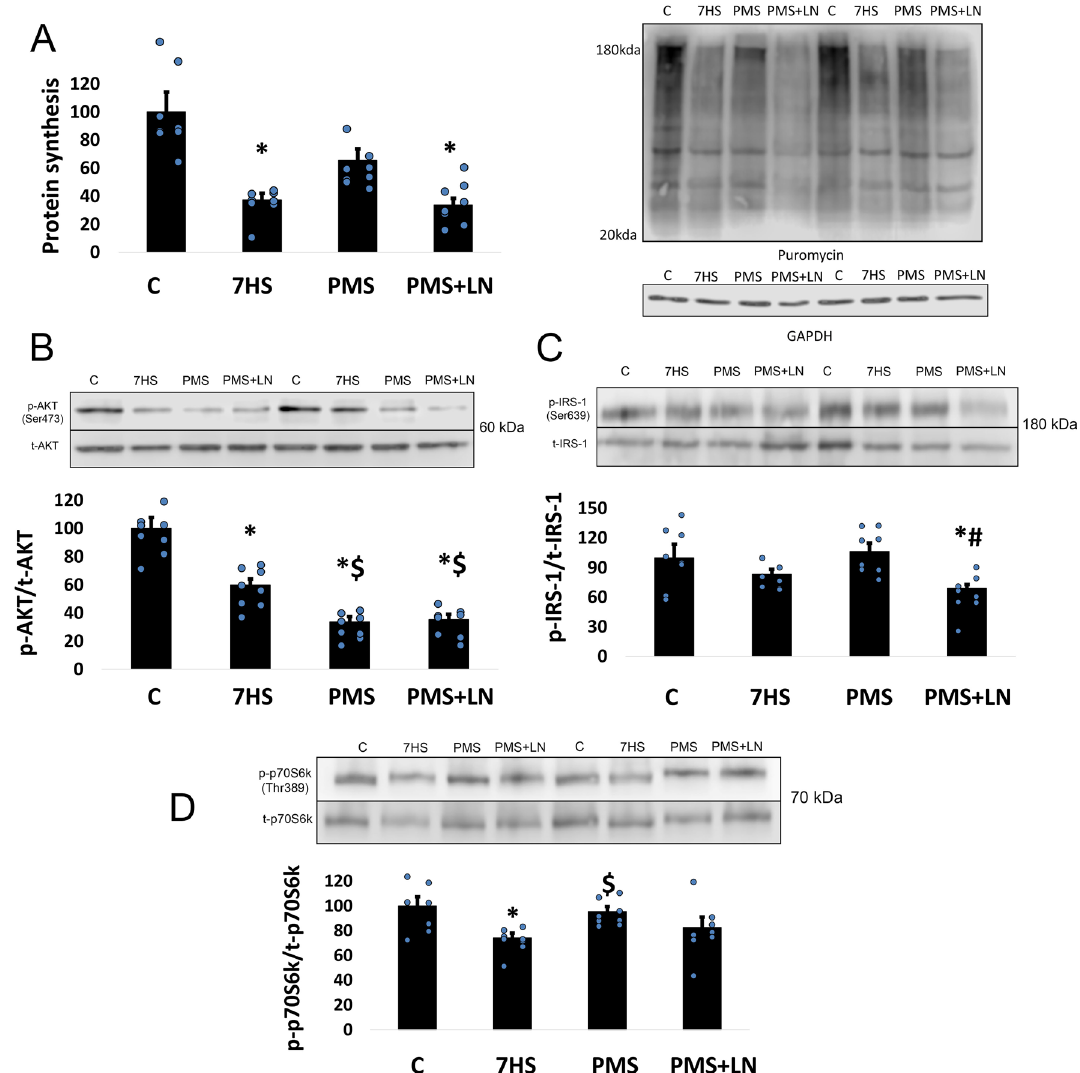
Figure 3. ( A ) Quantification of protein synthesis level. ( B ) Quantification of phospho-AKT (Ser473)/total AKT ratio. ( C ) Quantification of phospho-IRS-1 (Ser639)/total IRS-1 ratio. ( D ) Quantification of phospho-p70S6k (Thr389)/total p70S6k ratio. Control group ( C ); 7-days hindlimb-suspended group (7HS). 7-days hindlimb suspended group with plantar mechanical stimulation (PMS); 7-day hindlimb suspended group with plantar mechanical stimulation + L-NAME injection (PMS + LN). Data shown as % of control group. *Significant difference from control group. # Significant difference from PMS. $ Significant difference from 7HS ( p < 0.05). Blue dots correspond to the number of samples. The quantification of the proteins was performed using Image Studio Digits 4.0.21 software (https:// www. licor. com/ bio/ image-